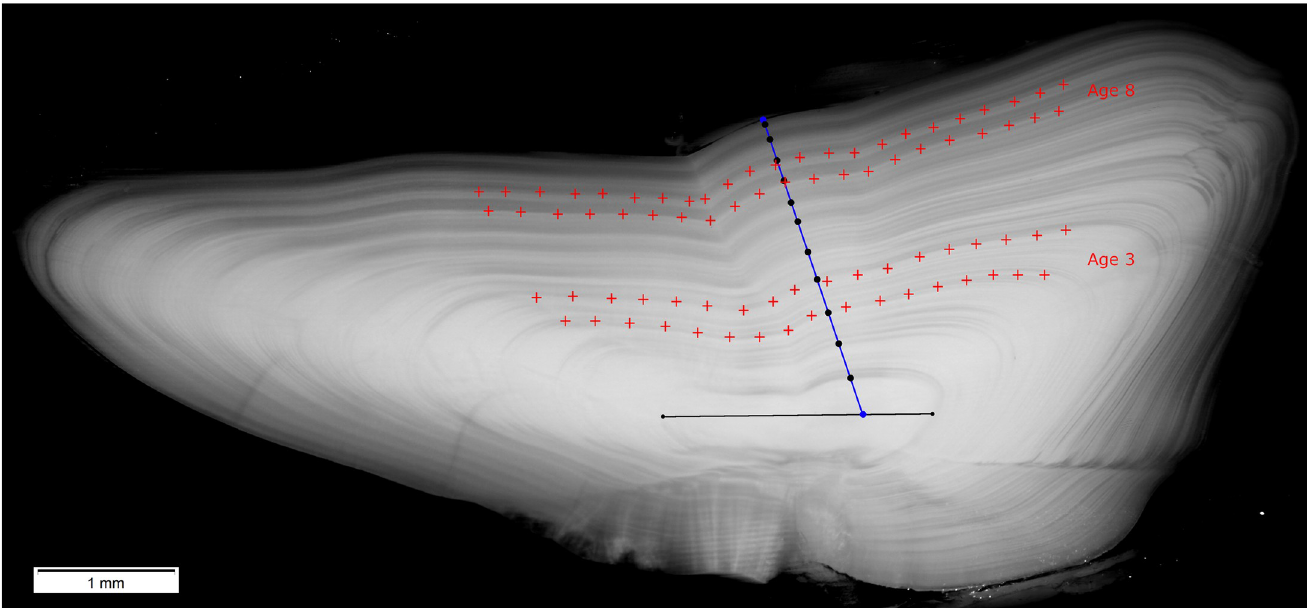
Fig 2. Example of a cod otolith section showing the increment measurement axis (blue) and milled regions (growth increments formed at age 3 and 8 are located between red crosses).